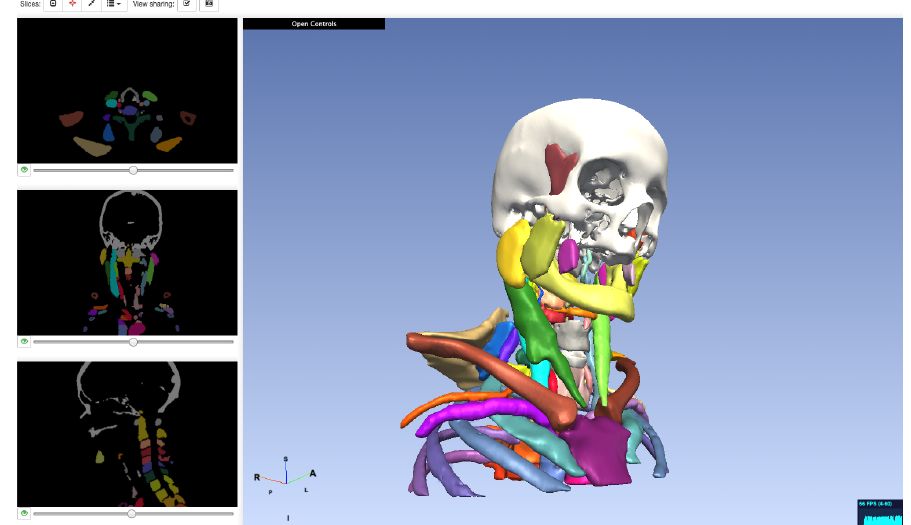
Figure 1. Screenshot of the Open Anatomy Browser with the 3D human head and neck atlas from the projects’ website https://www.openanatomy.org/ [35] showing bones and cartilage in different colors and a cross-sectional panel on the